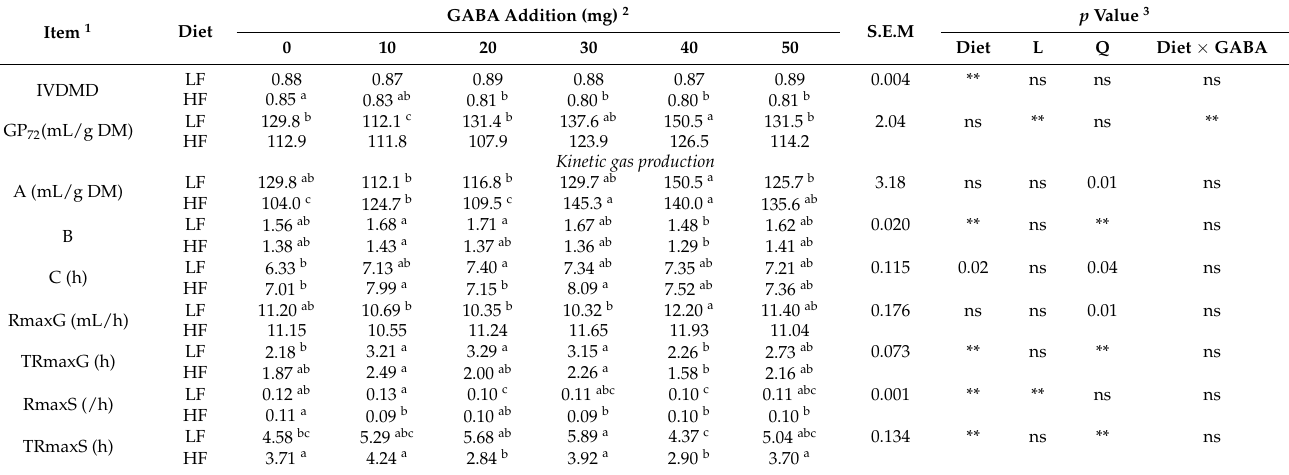
Table 2. Effect of different addition levels of gamma-aminobutyric acid (GABA) in culture fluids on in vitro dry matter disappearance (IVDMD) and kinetics of gas production of the high-fiber (HF) and the low-fiber (LF) with rumen fluids obtained from dairy